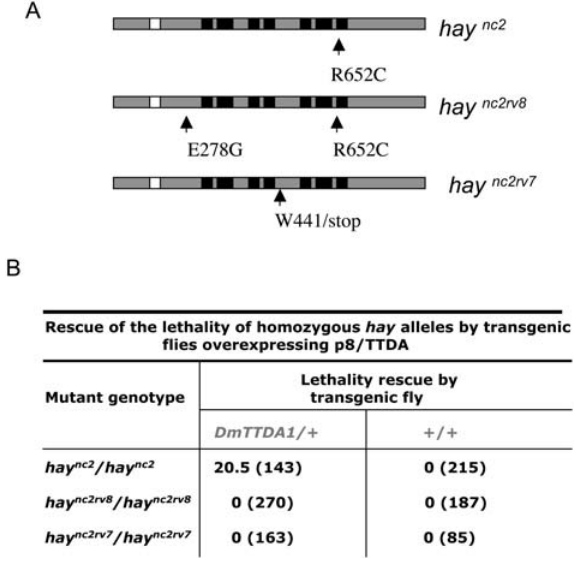
Figure 3. Rescue of haywire mutants by transgenic flies overexpressing Dmp8/TTDA. (A) Schematic diagrams of the different hay ( DmXPB ) mutant alleles used in this work. The molecular characterization of the mutants has been previously described [17]. hay nc2 and hay nc2rv8 alleles are conditional mutations that are homozygous lethal at the non-permissive temperature (25 u C). hay nc2rv7 generates a truncated Hay protein. The black boxes represent the helicase motifs and the white box the ATPase domain. (B) The rescue of homozygous hay alleles lethality by a Dmp8/TTDA transgene is show in table format. The percentage represents the number of homozygous individuals recovered relative to that expected with full complemen- tation (number in